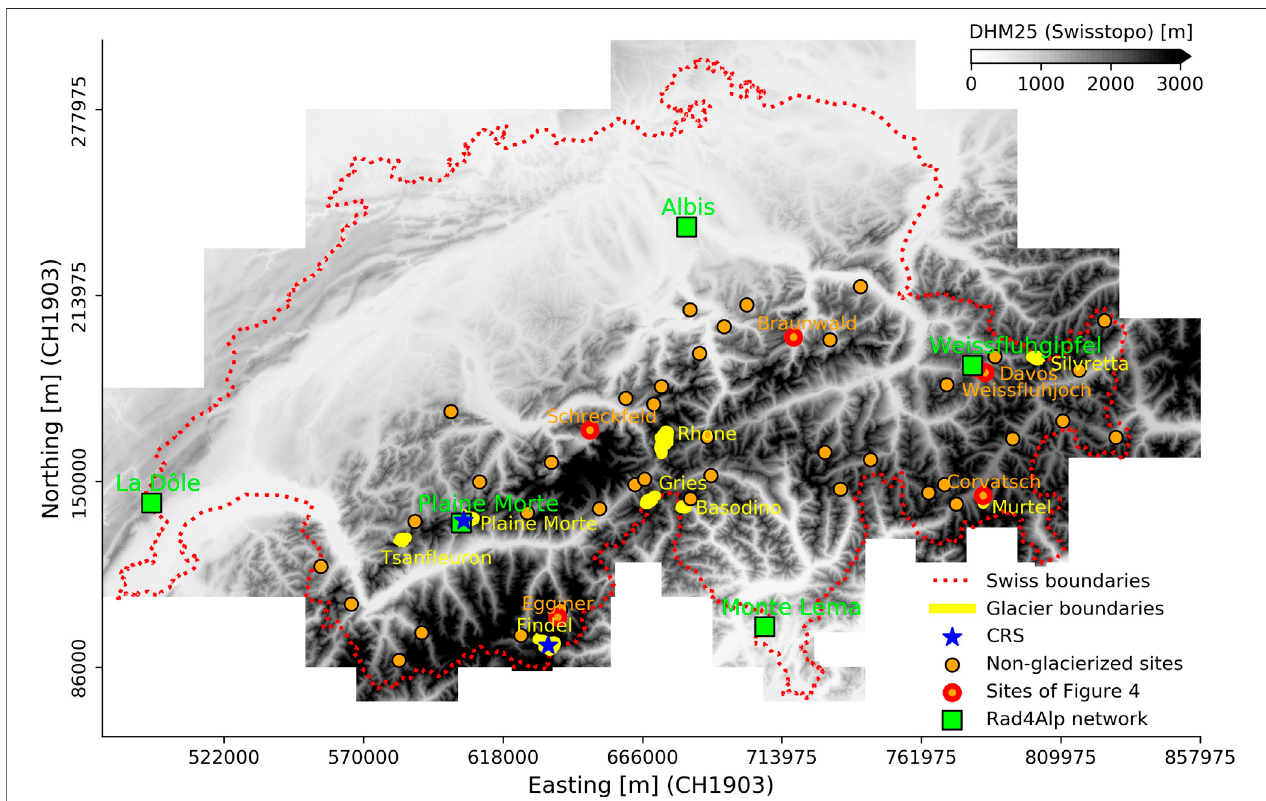
FIGURE 1 | Distribution of the RAD4Alp weather radars, the CRSs, the considered glaciers with the end-of-season in-situ measurements and the non-glacierized sites with twice-monthly SWE measurements.